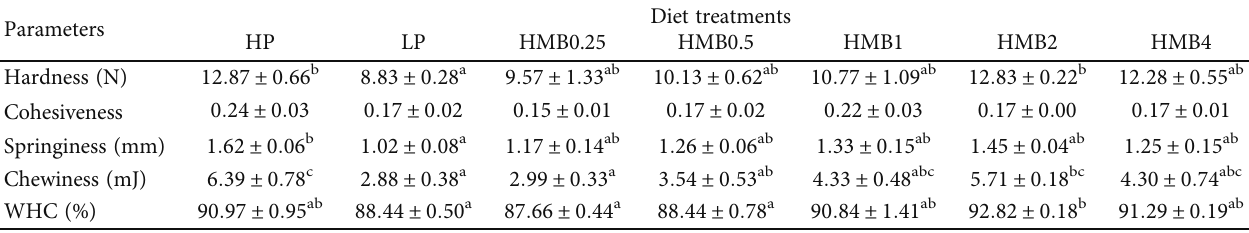
Table 7: Muscle texture and water holding capacity of kuruma shrimp fed with the experimental diets. Parameters